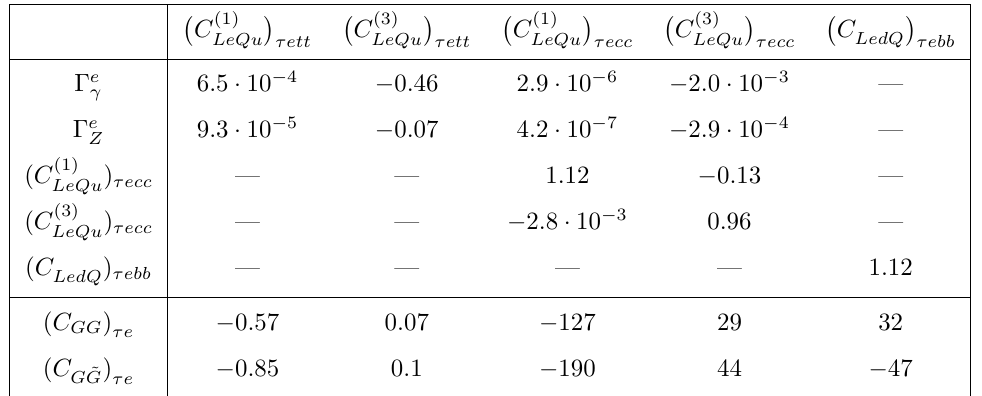
and C GG G ˜ G ( m ) for the top t b